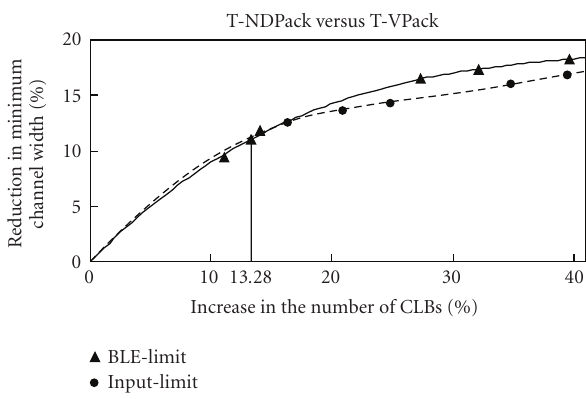
Figure 8: “ x -axis”: increase in the number of CLBs, “ y -axis”: reduction in minimum channel width relative to T-VPack. Solid line represents: T-NDPack with “BLE-limit” strategy. Dashed line represents: T-NDPack with “input-limit” strategy. As number of CLBs increase, minimum channel width decreases for both